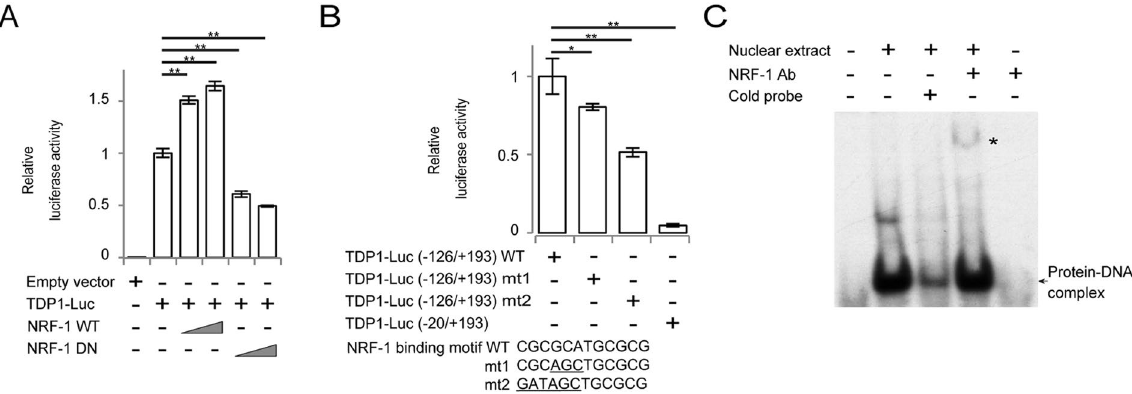
Figure 2. Identification of NRF-1 as a positive regulator of TDP1 . ( A ) Effects of NRF-1 and its mutants on the luciferase activity of the TDP1 promoter. 0.2 µ g of TDP1-Luc ( − 126/ + 193) was transfected into HEK293T cells with or without vectors expressing wild-type (WT) (0.1 μ g or 0.2 μ g) or dominant-negative mutant (DN) (0.025 μ g or 0.05 μ g) of NRF-1. Relative luciferase activity was calculated by comparison with the basal luciferase activity of TDP1-Luc. Data shown are the mean ± SD ( n = 3). ( B ) Effects of a mutated sequence of the NRF-1-binding motif on the luciferase activity of the TDP1 promoter. Wild-type TDP1-Luc ( − 126/ + 193), mutated TDP1-Luc ( − 126/ + 193) (mt-1 and mt-2), or TDP1-Luc ( − 20/ + 193) was transfected into HEK293T cells. Relative luciferase activity was calculated by comparison with the basal luciferase activity of TDP1-Luc. Data shown are the mean ± SD ( n = 3). ( C ) NRF-1 binds the promoter of TDP1 in vitro . A gel-shift assay was performed to analyze protein-DNA interactions. The NRF-1 protein-DNA complexes are indicated by the arrow. Supershift experiments were performed with anti-NRF-1